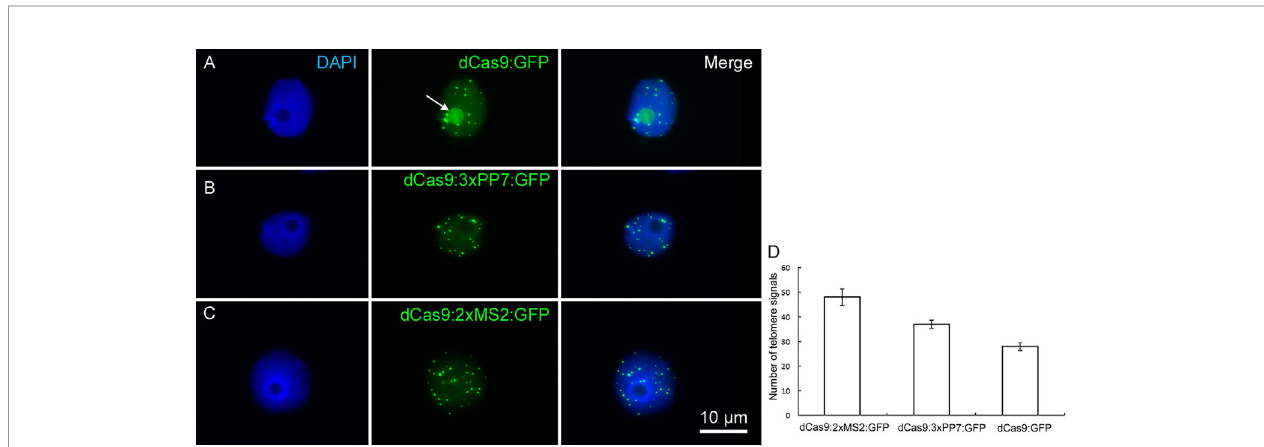
FIGURE 2 | Live imaging of telomeres in N. benthamiana leaf cells during interphase by CRISPR/dCas9. The distribution of telomeres recognized by (A) dCas9: GFP, (B) dCas9:3xPP7:GFP, and (C) dCas9:2xMS2:GFP. Note, aptamer-based imaging constructs (dCas9:3xPP7:GFP and dCas9:2xMS2:GFP) did not label nucleoli, while the application of dCas9:GFP does (nucleolus shown with white arrow). Nuclei are counterstained with DAPI (1.5 µg/ml) in VECTASHIELD. (D) Diagram showing the ef fi ciency of indirectly and directly labeled dCas9 for targeting telomeric regions. The number of telomere signals was determined based on 20 nuclei per construct. dCas9 indirectly labeled either with MS2 or PP7 aptamers shows more telomeres (p <